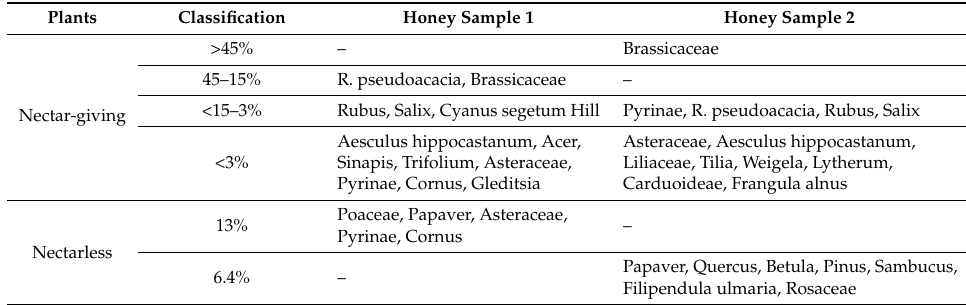
Table 4. Microscopic pollen analysis of nectar-giving plants (first row) and nectarless plants (second raw) from two honey samples (DIN 10760 (a) (A))